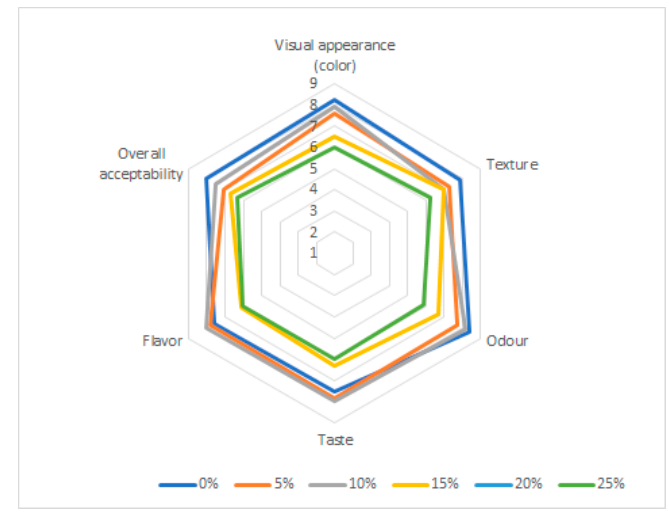
Figure 3. Hedonic scores for enriched biscuits with spent malt rootlets in different concentrations